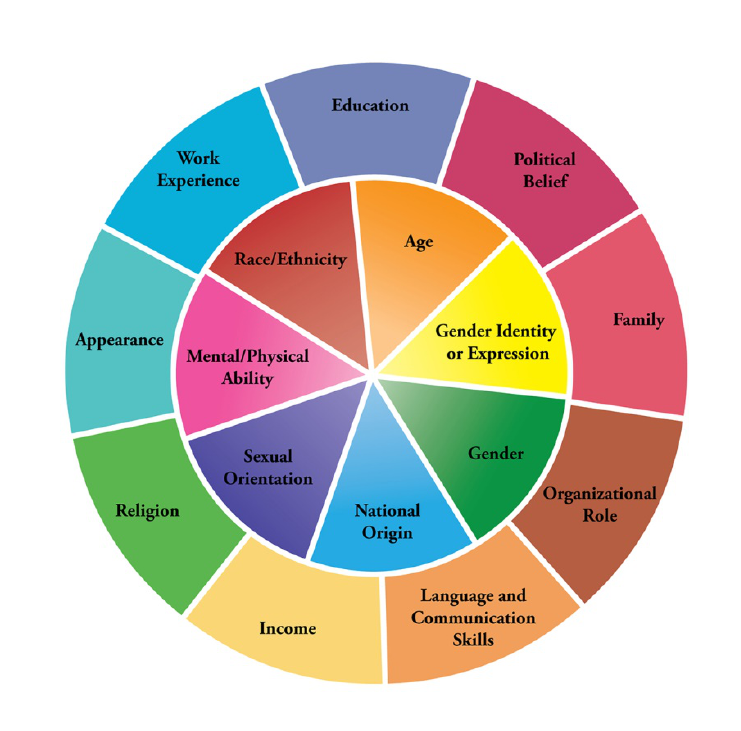
Figure 1 Diversity Wheel as used at Johns Hopkins University